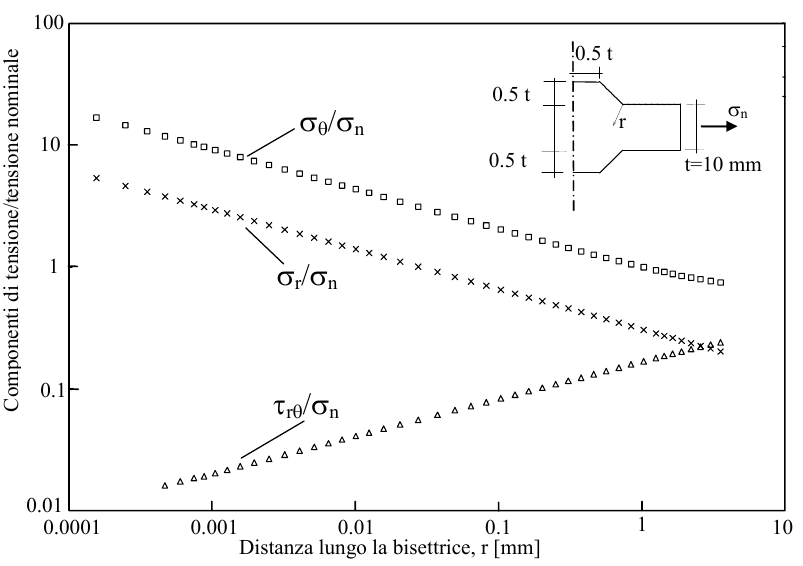
Figura 2: Componenti di tensione di modo I e di modo II lungo la bisettrice dell’intaglio [4].